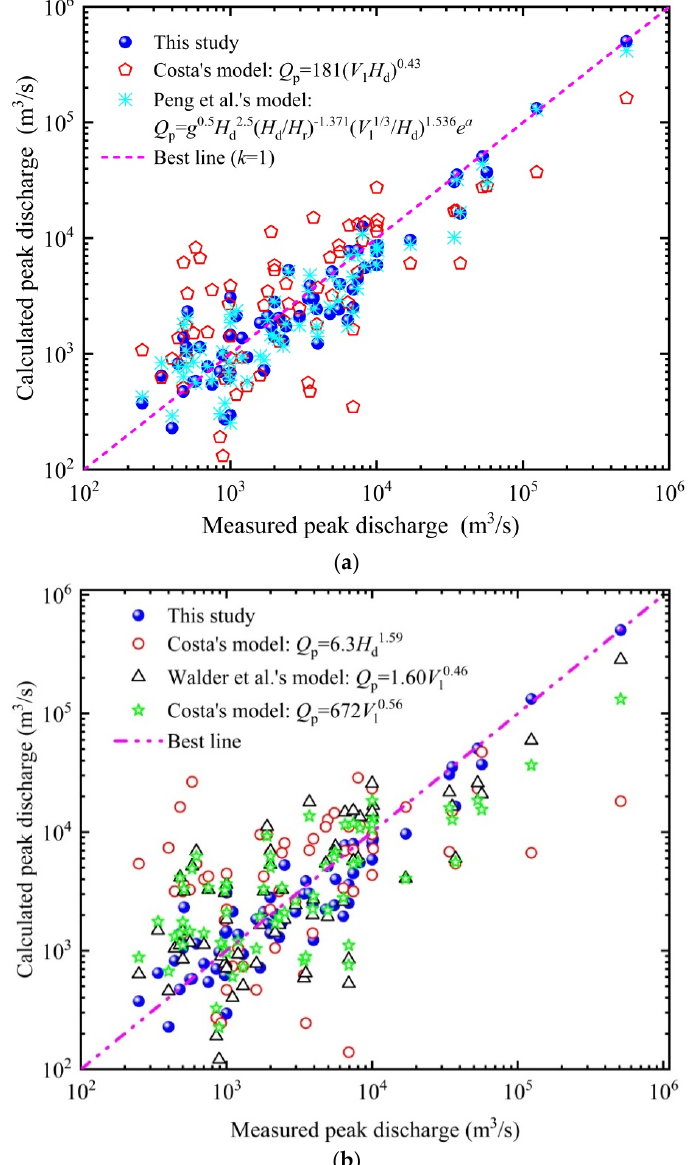
Figure 2. Comparison of calculated results of different models. ( a , b ) are separated from the same figure, because if all models are put into the same graph with too many data points, it is difficult to distinguish the calculation accuracy of each